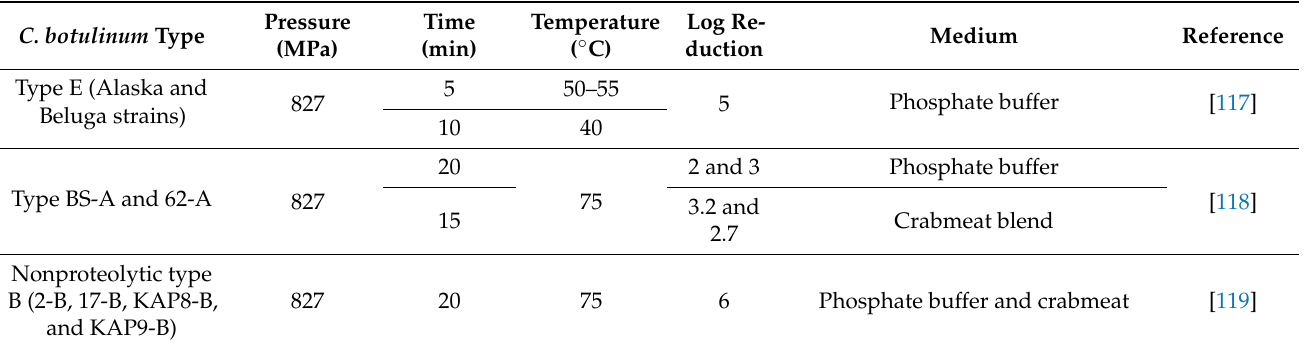
Table 5. Pressure, time, and temperature combinations to reduce the viability of C. botulinum spores in different